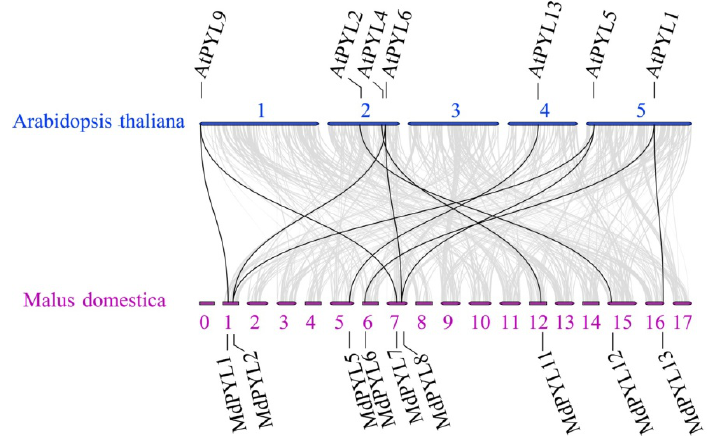
Figure 5. Synteny analysis of PYL s between apple and A. thaliana . Gray lines denote the collinear blocks between apple and A. thaliana genomes and the black lines denote the syntenic gene pairs of PYLs . Blue and purple lines represent respectively the apple chromosomes (0–17) and Arabidopsis chromosomes (1–5).